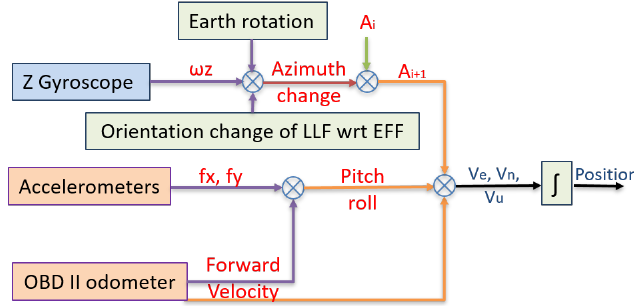
Figure 6. Typical 3D RISS navigation system scheme based on onboard sensors and vehicle